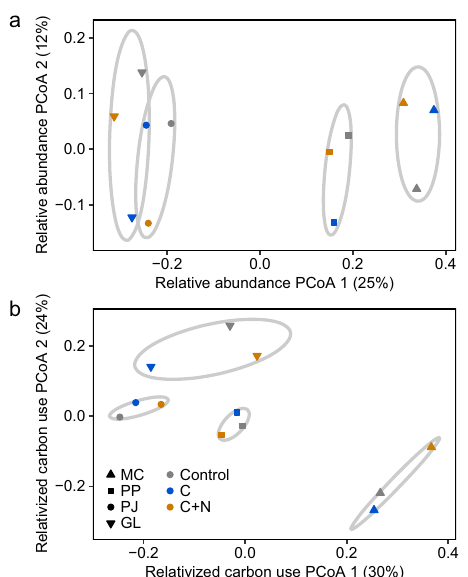
Fig. 5 Composition of abundance and carbon use. Ordinations generated by principal coordinates analysis (PCoA) of Bray – Curtis dissimilarities. Points represent centroids across replicates for each ecosystem (symbol MC mixed conifer forest, PP ponderosa pine forest, PJ piñon pine-juniper scrubland, GL desert grassland) and treatment (color control no amendment, C = carbon — glucose — only, C + N = carbon and nitrogen — [NH 4 ] 2 SO 4 ) ( n = 3 experimental replicates). Ellipses represent multivariate standard error ranges for ecosystem group position (95% con fi dence). Percentages along axes represent the percent of multivariate dispersion explained by each PCoA dimension. a Beta diversity of relativized abundances. b Beta diversity of relativized carbon use values (respiration plus biomass production, μ g carbon per g soil per